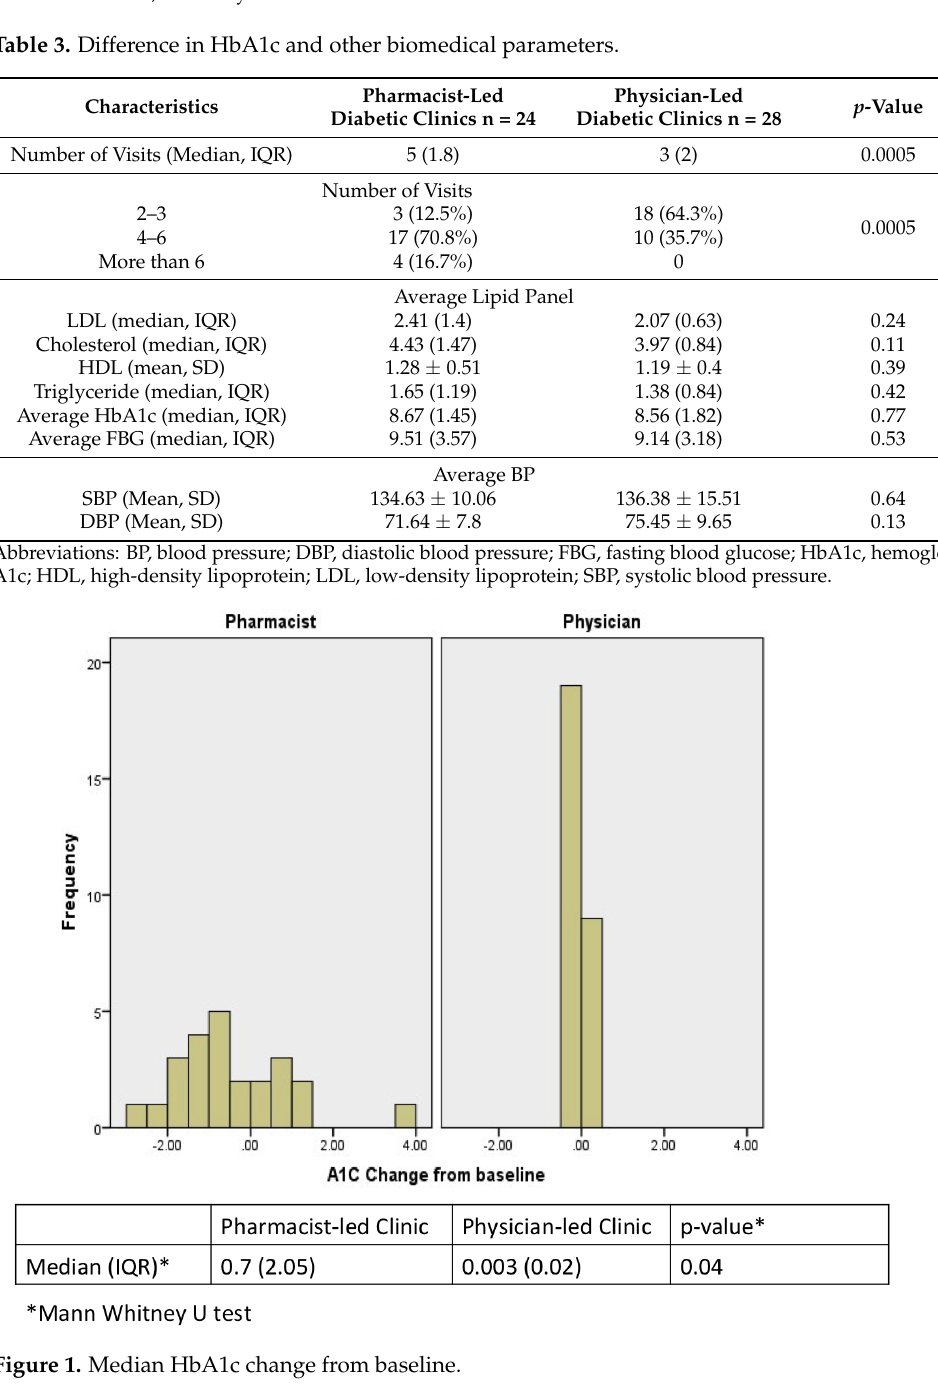
pants (three refused and seven did not answer) were in the physician-led diabetic clinics. The average of responses in all four aspects of the questionnaire (diet, exercise, blood sugar testing, and foot care) was higher among patients in the pharmacist-led diabetic clinic compared with those in the physician-led diabetic clinics (Figure 2). Compliance with medication usage was the same between both groups. Smoking was reported in one patient at pharmacist-led diabetic clinic with daily reported average of 45 cigarettes per day, while two patients were smokers in physician-led diabetic clinics group with daily reported average of 20 and 15 cigarettes per day.